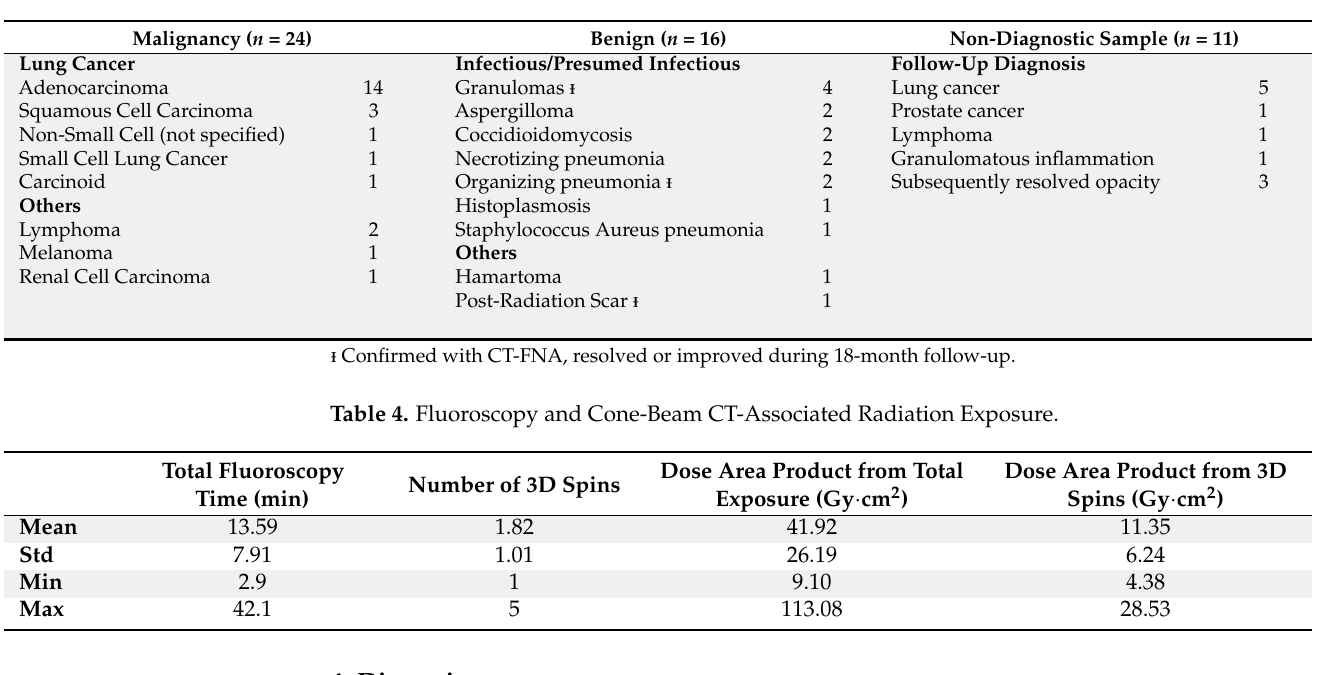
Table 3. Diagnosis Obtained with Bronchoscopy.